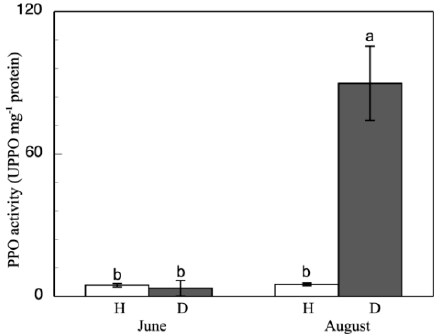
Figure 2. PPO activity in grapevine healthy (H) and esca-diseased (D) leaves from June and August. The data are means ± SD from 10 independent experiments, each carried out in triplicate (different letters indicate significant differences at p < 0.05, Mann–Whitney U test).